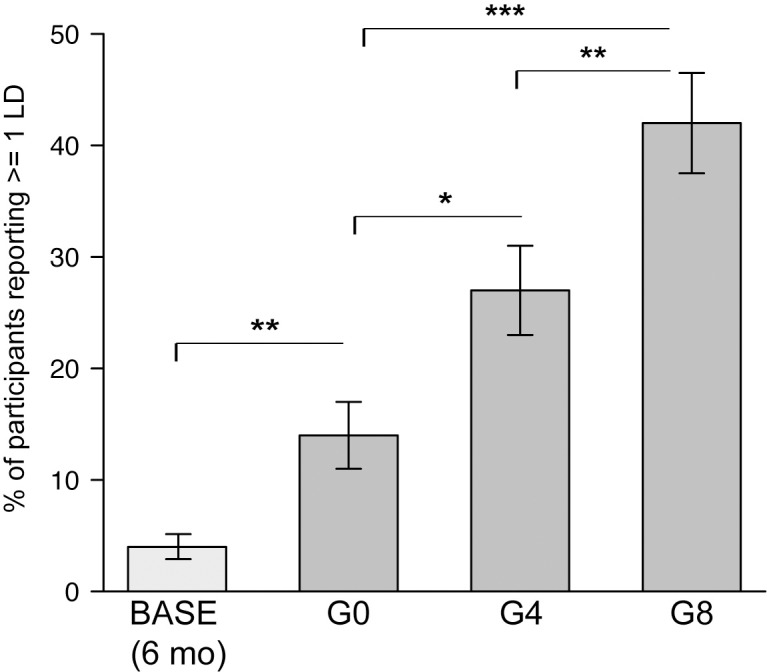
Percent of participants (N = 121) reporting at least one lucid dream (LD) on returning to sleep following ingestion of one of three masked doses of galantamine (0 mg [G0], 4 mg [G4], and 8 mg [G8]) prior to 30–40 minutes out of bed.The baseline estimate (“BASE”, 4%) of lucid dreaming frequency for one night was calculated from the self-reported estimates of how many LDs participants experienced in the previous six months, divided by 180. [95% CI computed by resampling.] Error bars show estimated standard error of the conditional means. Asterisks indicate statistically significant differences between conditions: * p<0.05; ** p<0.01; *** p<0.001.